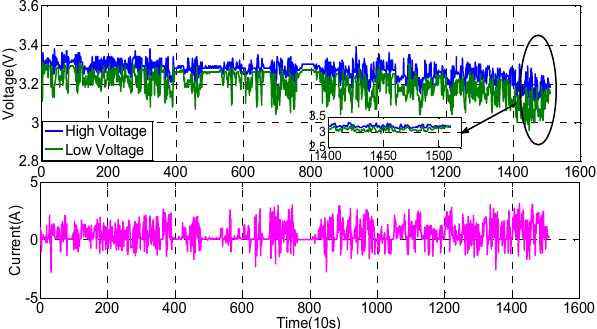
Figure 12. The highest and lowest cell voltages as well as the cell current.